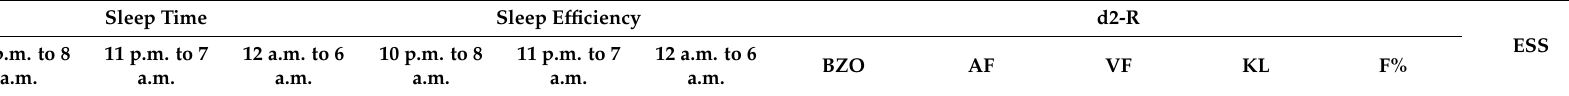
Table 6. Pearson correlation matrix of sleep, daytime sleepiness, and concentration during the night shift. AF, “Auslassungsfehler“/omissions, BZO, “bearbeitete Zielobjekte”/number of completed objects; CI, confidence interval; ESS, Epworth Sleep Scale; F%, “Fehlerquote”/mistake rate; KL, “Konzentrationsleistung”/concentration, SD, standard deviation; VF, “Verwechslungsfehler”/mix-up mistakes. ** p <